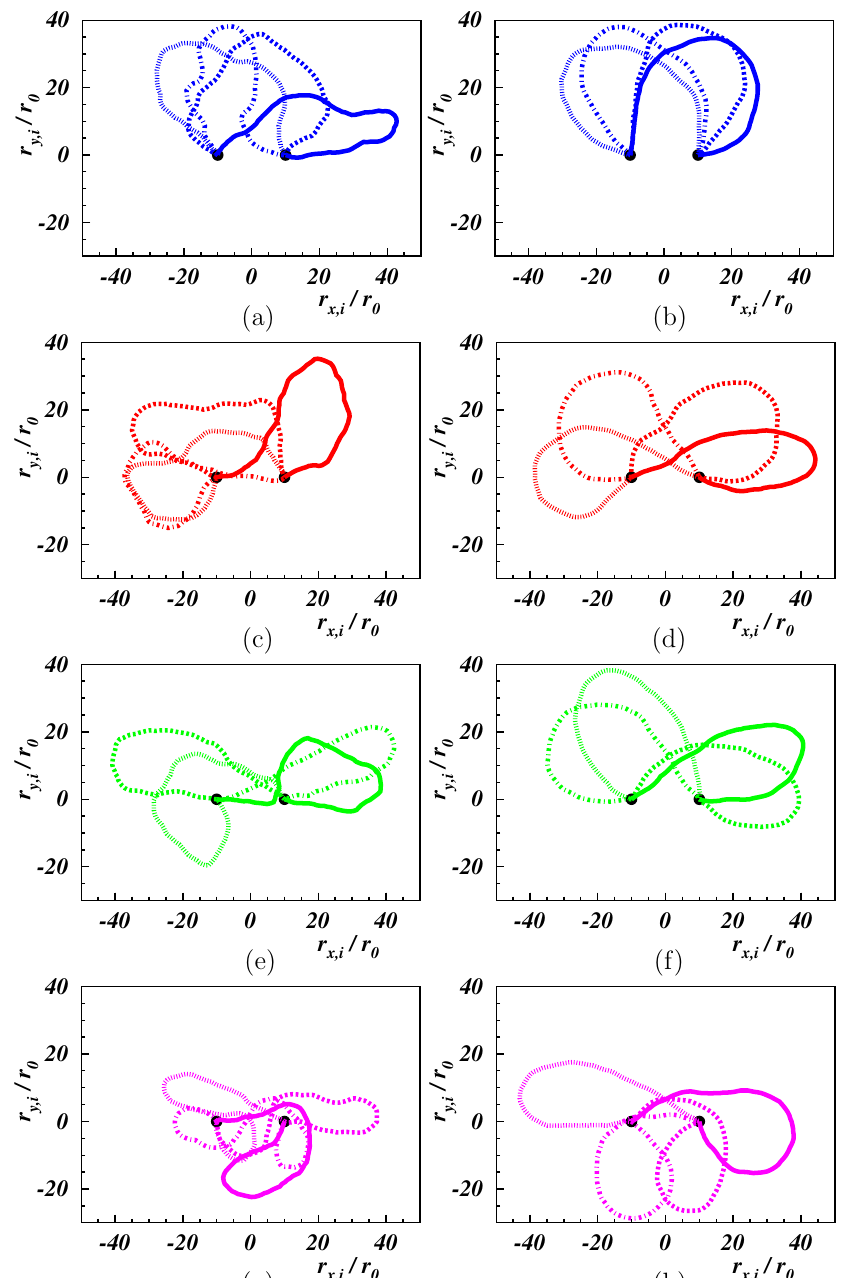
Figure 2. Conformations of the polymer at times t = 0 (solid line), 0.5 π / ω (dashed line), π / ω (dotted line), 1.5 π / ω (dash-dotted line) after equilibration for L p / L = 0.5 ( left ), 2 ( right ), and Wi = 10, 25, 50, 100 ( from top to bottom ). Black dots denote the position of fixed